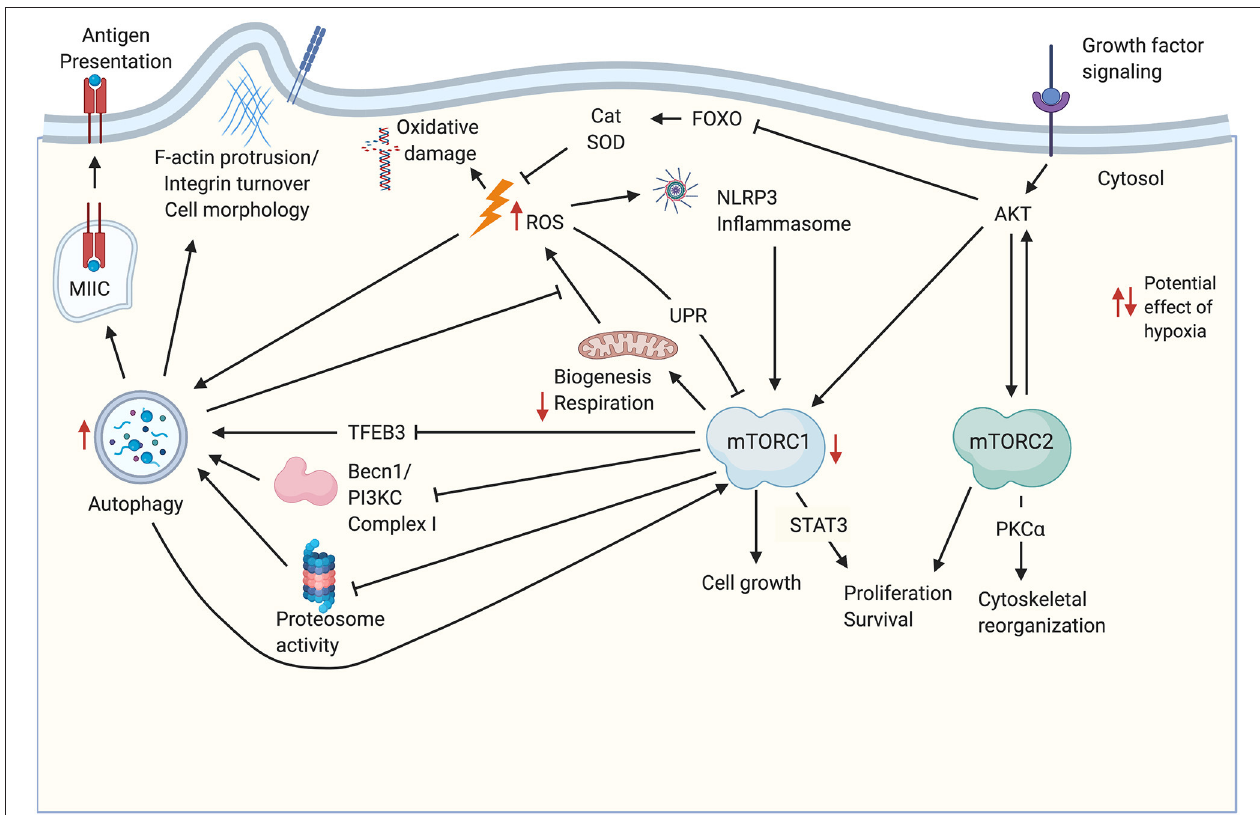
FIGURE 1 | Potential cross-talk and co-regulation of mTOR signaling, ROS, and autophagy in TEC. Growth factor signaling induces AKT activation upstream of mTORC1/mTORC2 complexes. Both complexes promote cell proliferation and survival. mTORC1 signaling drives biogenesis including production of mitochondria required for oxidative phosphorylation. Increased metabolism leads to increased byproducts of metabolism including ROS, which can damage DNA and other macromolecules, including mitochondrial damage that exacerbates ROS production. ROS production is also promoted through the AKT-mediated inhibition of FOXO transcription factors that regulate antioxidant enzymes like Cat and SOD. ROS can feedback to inhibit mTORC1 activity via the UPR, and can activate the NLRP3 inflammasome. ROS promote autophagy, which also mitigates mitochondrial damage by increasing turnover of damaged organelles. Autophagy also promotes antigen processing and presentation in TEC, and may influence cell morphology, for instance, through turnover of integrins. Autophagy is mitigated by mTORC1 signaling via decreases in TFEB-mediated transcription of autophagy genes, as well as inhibition of proteosome activity and autophagosome assembly. mTORC2 phosphorylates several PKC family members, including PKC α , which regulate cell morphology and size through the actin cytoskeleton. Potential impacts of hypoxia are indicated by red arrows. Created with BioRender.com. Becn1-PI3KC Complex, Beclin 1- phosphatidylinositol 3-kinase complex; Cat, catalase; Foxo, class O of forkhead box transcription factors; MIIC, MHC class II-containing compartment; PKC α , Protein Kinase C α ; SOD, superoxide dismutase; STAT3, signal transducer and activator of transcription 3; ROS, reactive oxygen species; TFEB3, transcription factor EB; UPR, unfolded protein